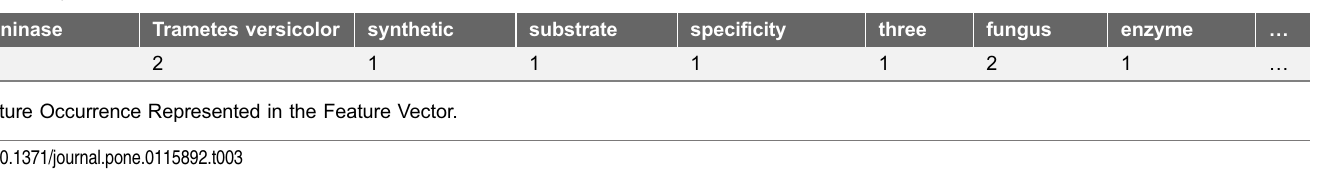
Table 3. mycoSet Feature Vector